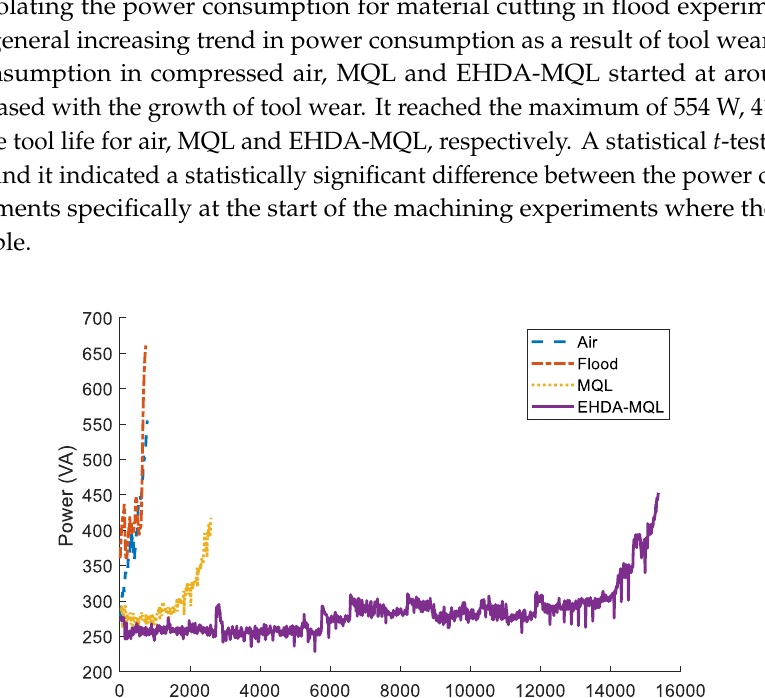
Figure 7. Power consumption against tool wear for various cooling-lubrication methods.